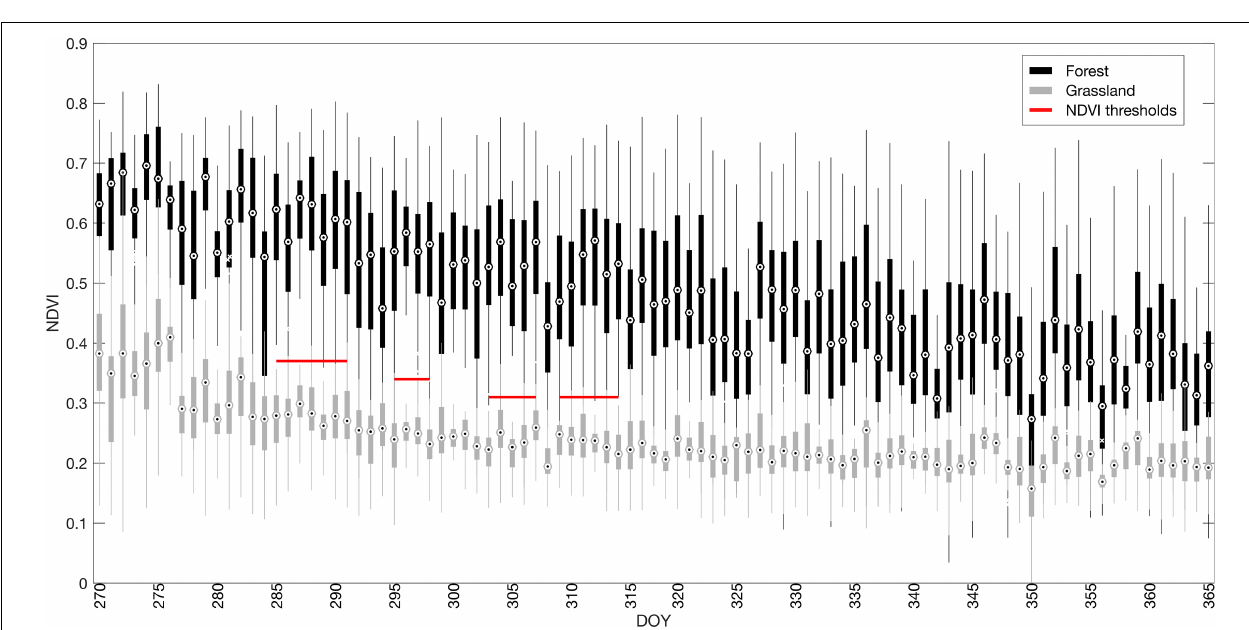
FIGURE 3 | ROI boundaries for the Dhofar cloud forest. The numbers depict the ROI ID and numbers marked with an asterisk depict ROIs based on several small catchment boundaries.